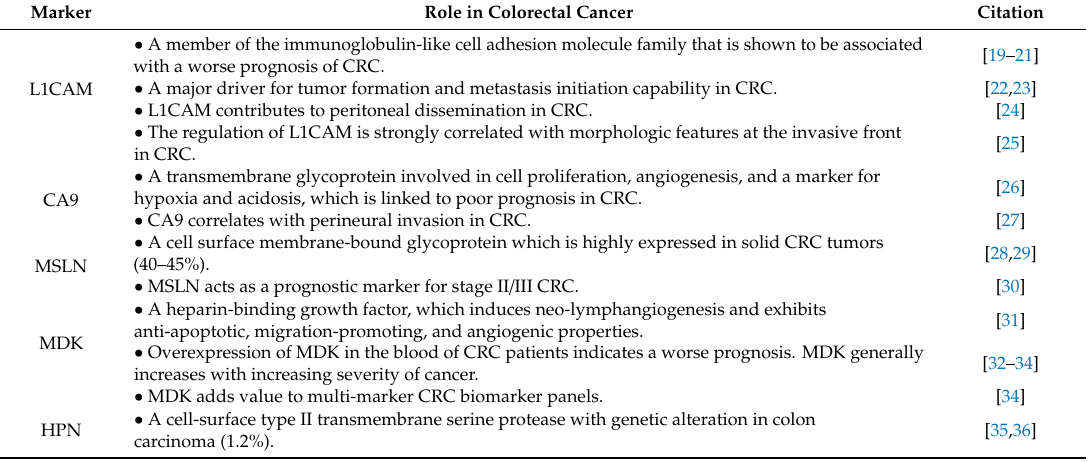
Table 1. Selection rationale of the 10 markers from the Human Circulating Cancer Biomarker Multiplex Immunoassay Magnetic Bead Panel